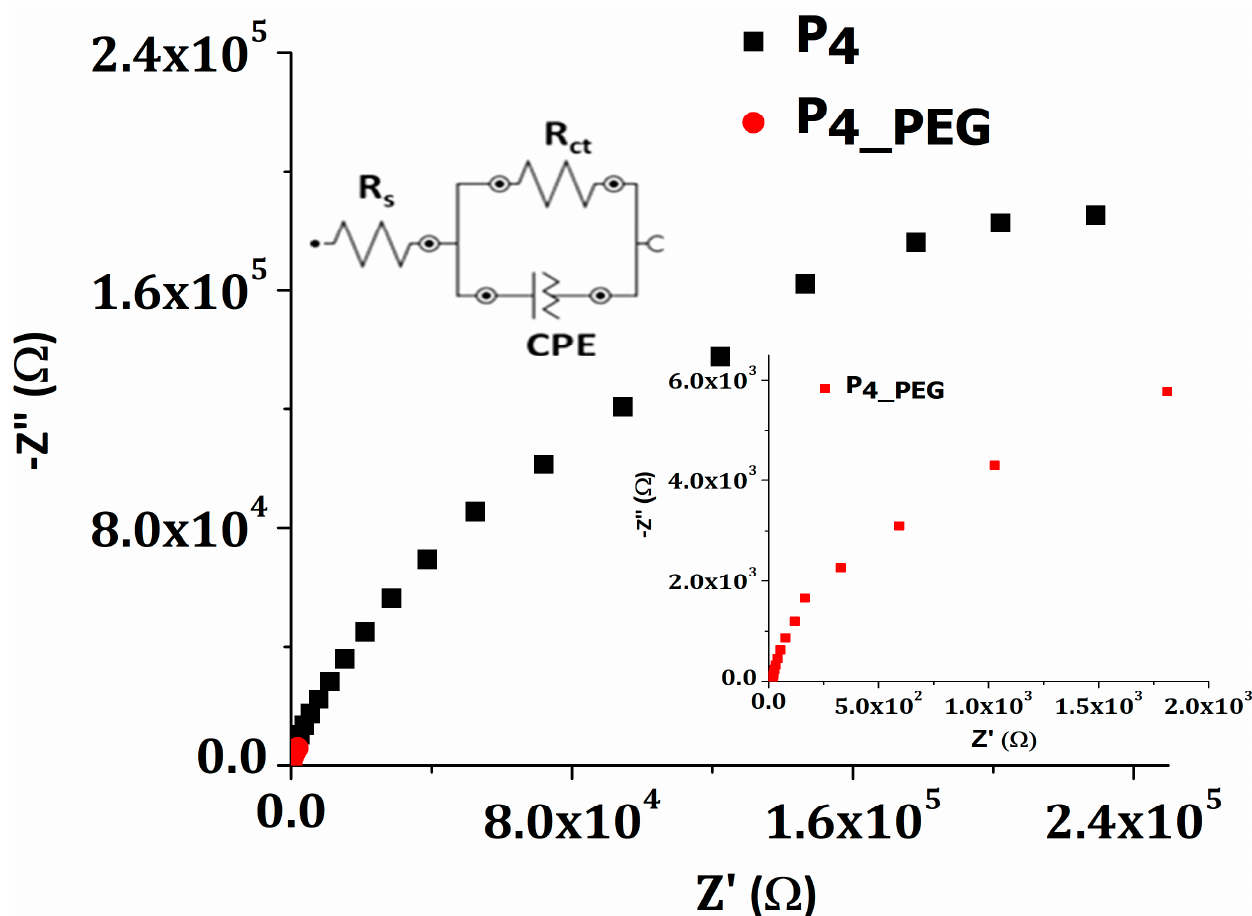
Figure 9. Nyquist plots for P 4 and P 4_PEG fi lms.